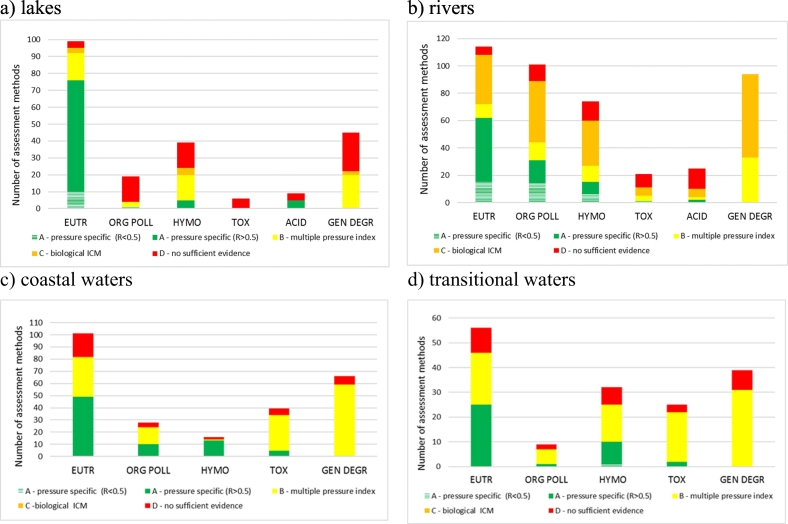
Number of national assessment methods for lakes, rivers, coastal and transitional waters addressing different pressures, with pressure-specific / multi-pressure / no relationships demonstrated. EUTR: eutrophication; HYMO: hydromorphology; ORG POLL: organic pollution; TOX: toxicity; ACID: acidification; GEN DEGR: general degradation. ICM: Intercalibration common metric.